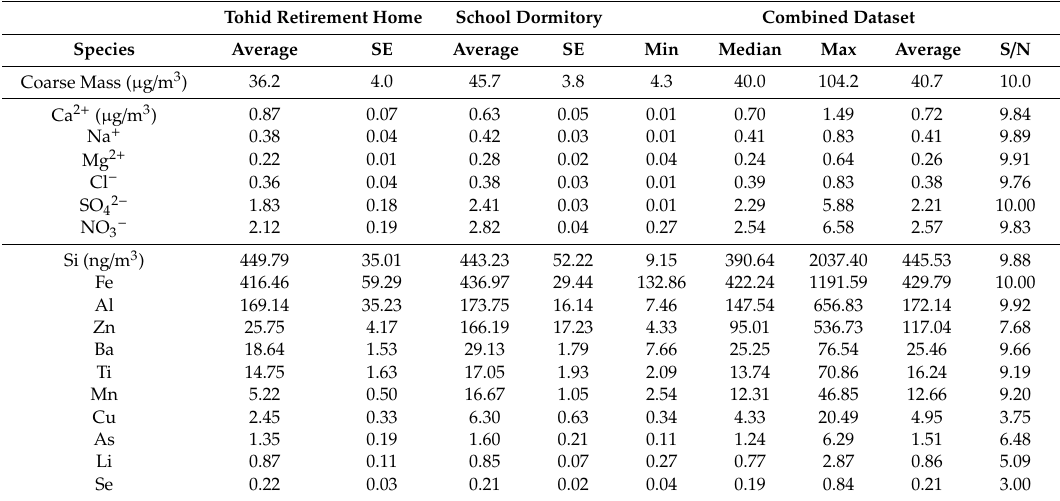
Table 1. Summary statistics of coarse PM and its chemical components for Tohid retirement home, School dormitory, and the combined